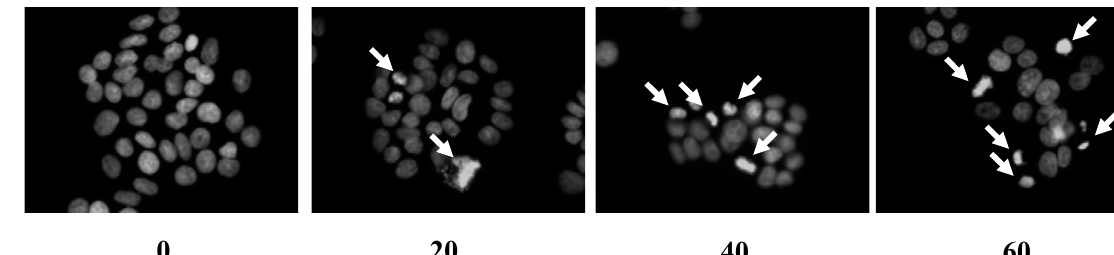
Figure 2. Effect of kaempferol on apoptosis of HT-29 cells. ( A ) Cells were plated in 4-well chamber slides and treated with various concentrations of kaempferol for 48 h. Cells were fixed and stained with Hoechst 33258. Arrows indicate apoptotic cells; ( B ) Cells were plated in 24-well plates and treated with various concentrations of kaempferol for 24 or 48 h. Cells were trypsinized, loaded with Annexin V and 7-amino-actinomycin D (7-AAD), and analyzed by flow cytometry. The percentages of early apoptotic cells (Annexin V + /7-AAD − cells) were calculated. Each bar represents the mean ± SEM ( n = 6); ( C ) Cells were plated in 100-mm dish and treated with various concentrations of kaempferol for 48 h.